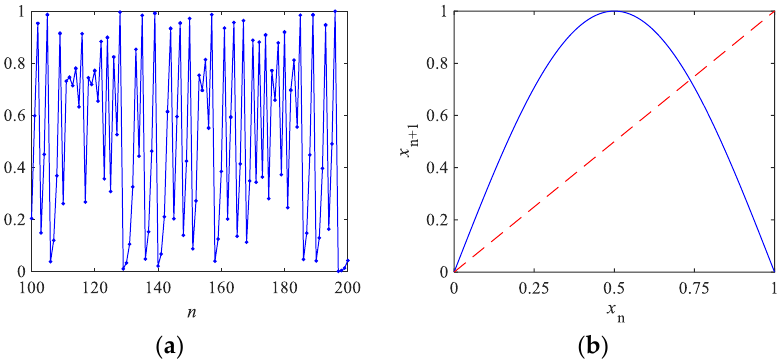
Figure 1. The time sequence and the phase diagrams of system (1): ( a ) The time sequence generated with system (1); ( b ) The phase diagram of system (1).